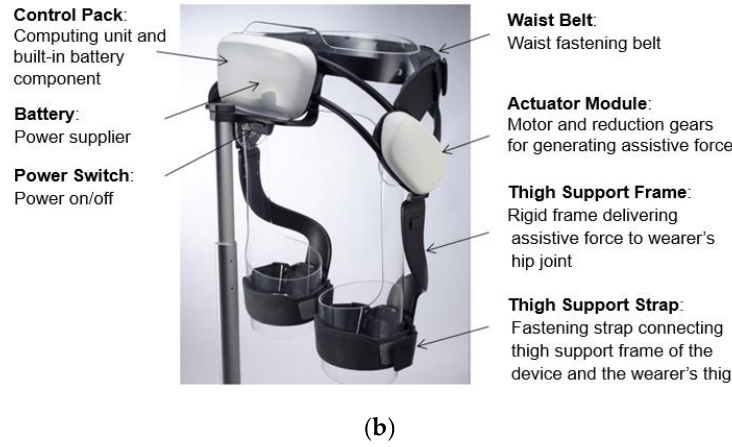
Figure 1. Wearable Hip Exoskeleton, EX1: ( a ) Exterior of EX1; ( b ) Description of the exterior.